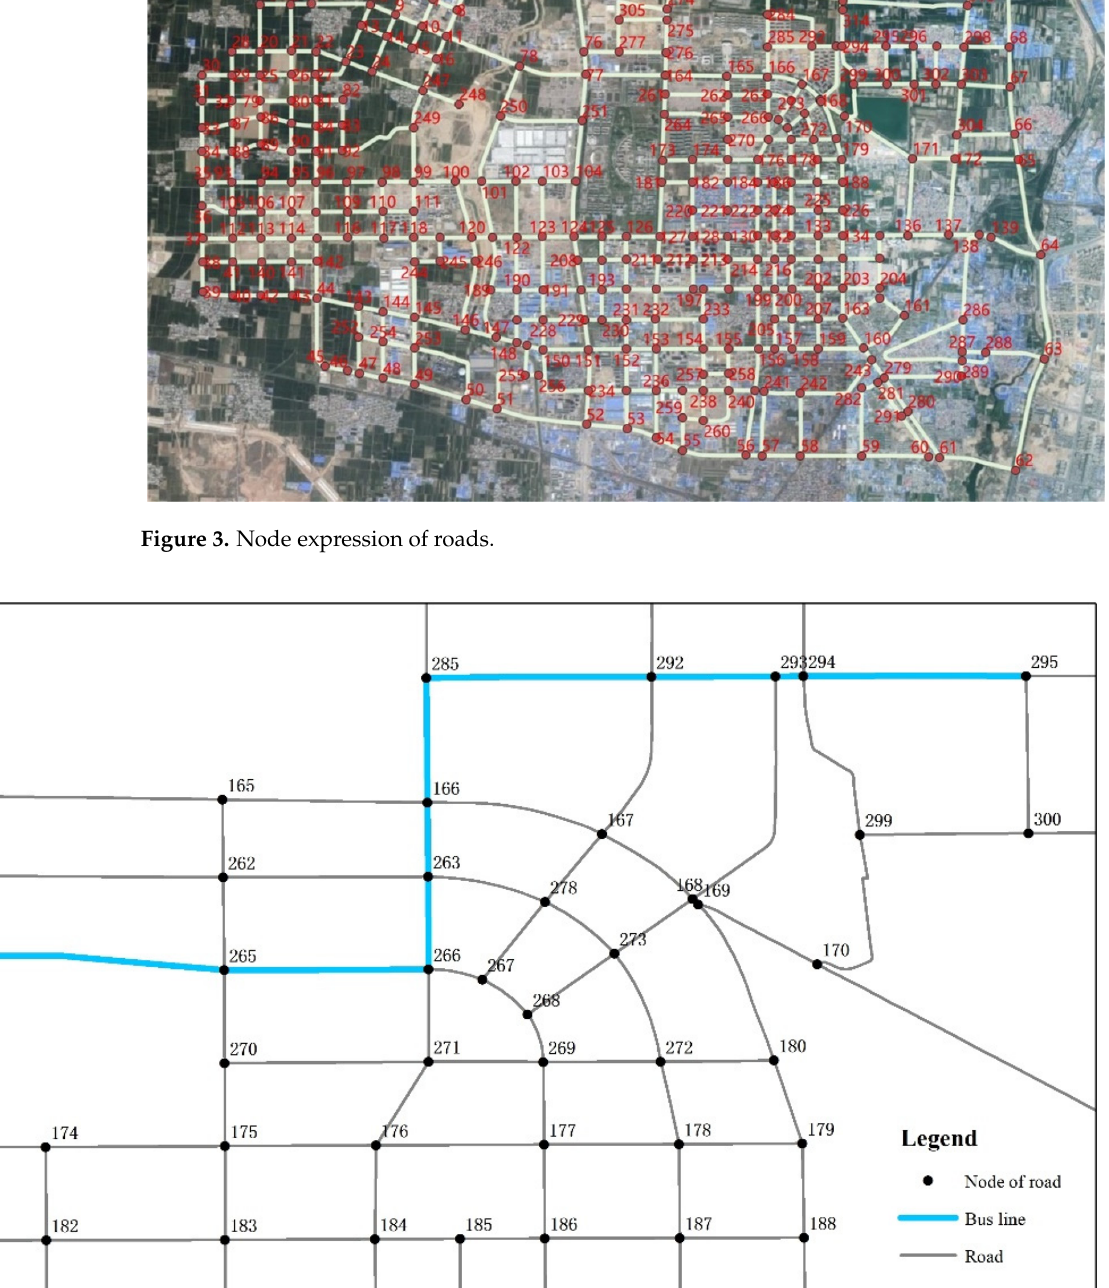
Figure 4. Example of node expression of public transport routes.